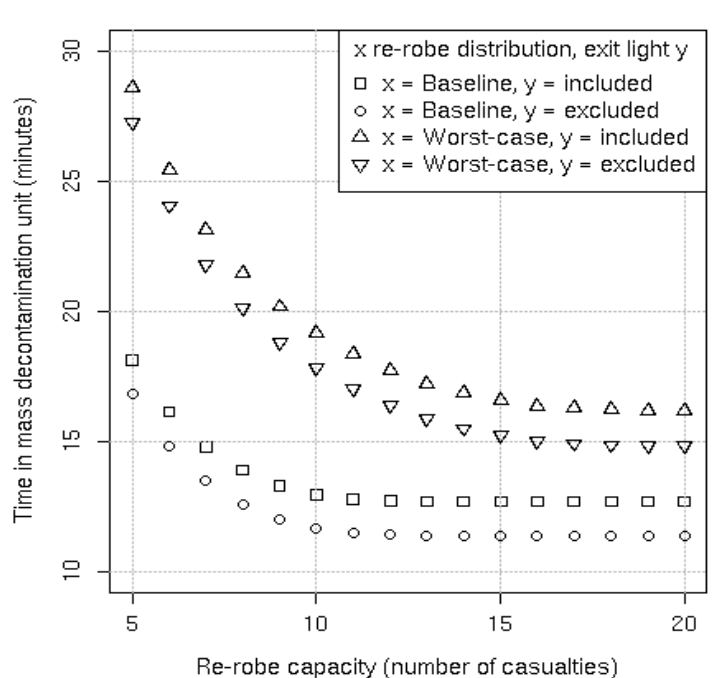
Figure 5. Average simulated results per lane with a three minute shower